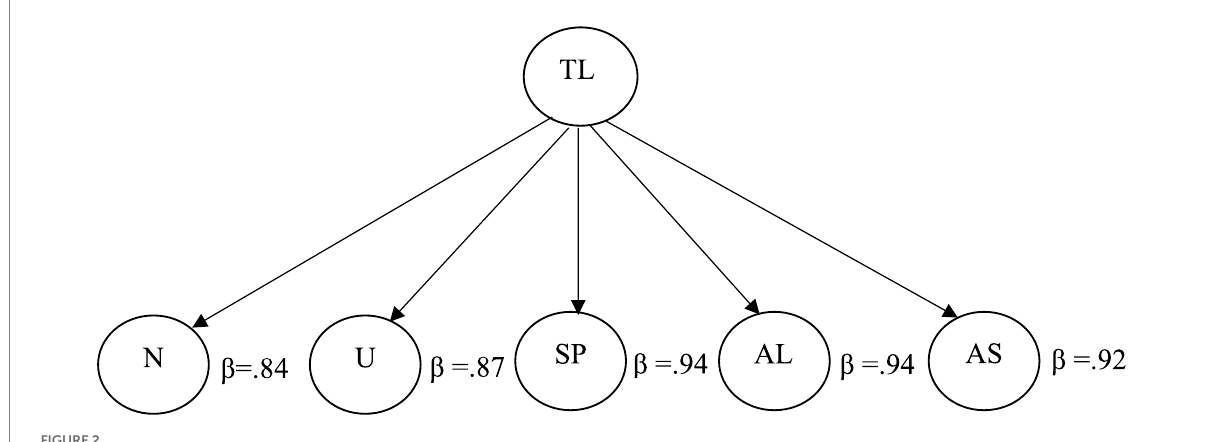
FIGURE 2 Second-order factor analysis of toxic leadership. TL, toxic leadership; N, narcissism; U, unpredictability; SP, self-promotion; AL, authoritarian leadership; AS, abusive supervision.